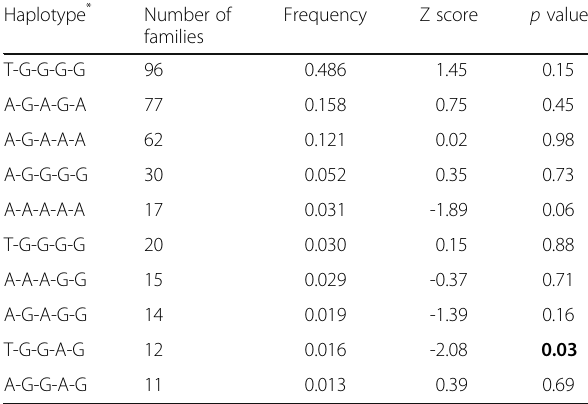
Table 4 Haplotype family-based association test for AXIN2